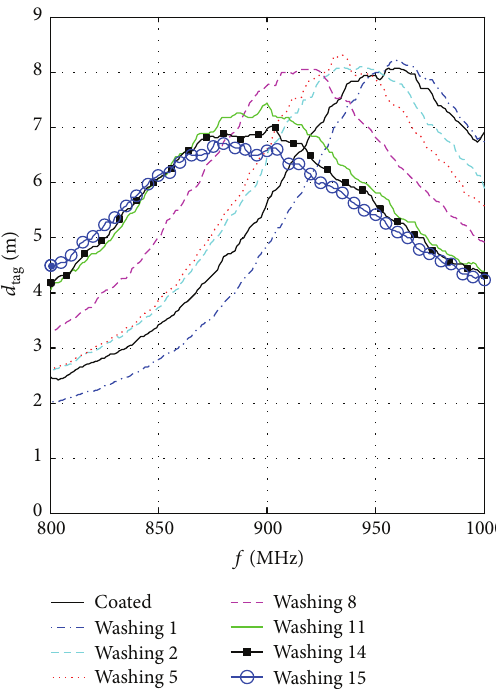
Figure 8: Measurement results for a tag where the peak read range was found to strongly shift to lower frequencies after each washing cycle.